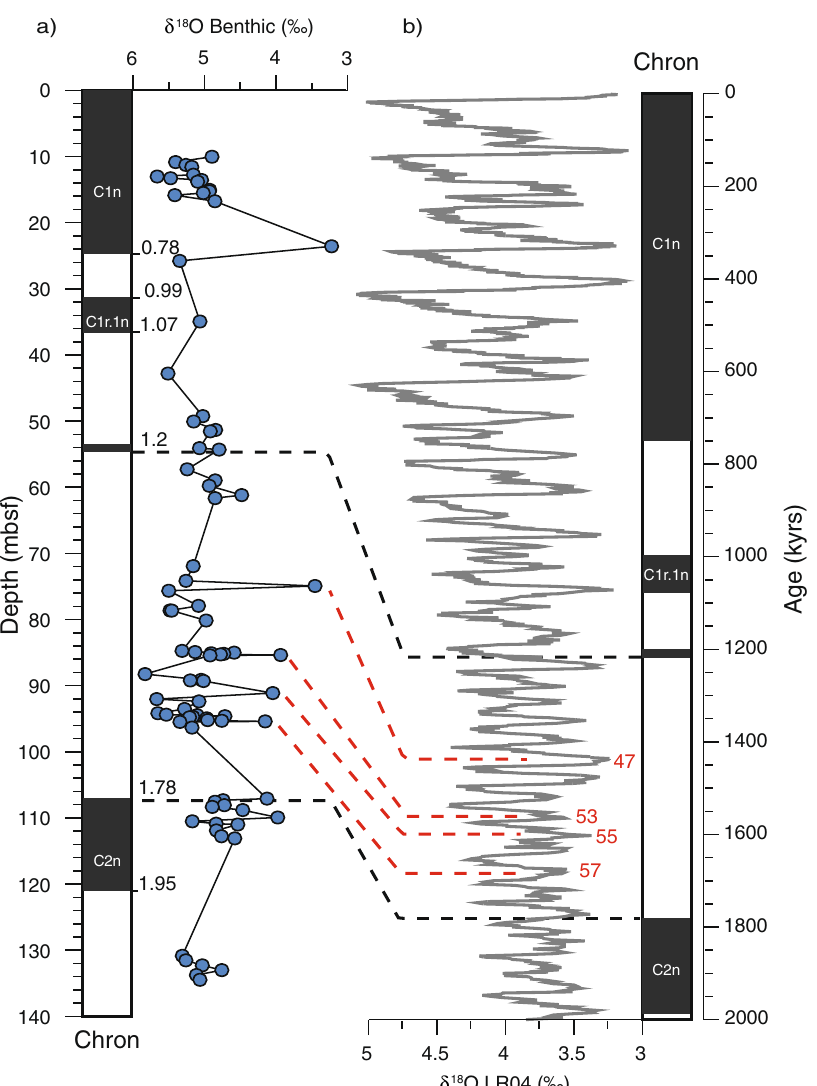
Fig. 2 Stratigraphic correlation of ODP Hole 912A with global records. a Palaeomagnetic interpretation 27 and new benthic stable oxygen isotope data in Hole 912A vs depth (metre below sea fl oor, mbsf). Ages for chron boundaries are according to ref. 93 . b Global LR04 stable oxygen isotope stack 30 and palaeomagnetic chrons vs age. Black stippled lines indicate magnetic chron boundaries between ~1.2 and ~1.8 Ma. Based on linear sedimentation rates between chron boundaries, interglacial marine isotope stages (MISs) 47, 53, 55, and 57 are identi fi ed by visual correlation of light stable oxygen isotope intervals (red stippled